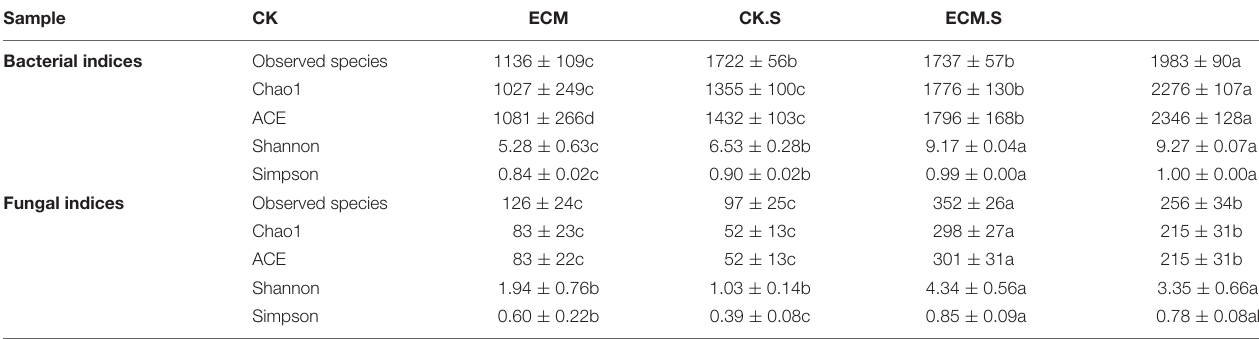
TABLE 1 | Community richness and diversity indices of bacteria and fungi in the roots and rhizosphere soil of Quercus aliena with or without Tuber indicum partner. Sample CK ECM CK.S ECM.S